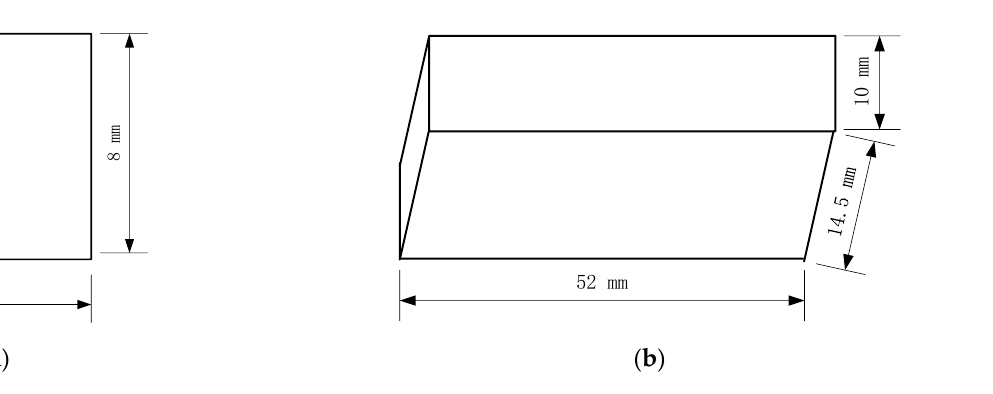
Figure 2. The SLM samples ( a ) Single layer sample (8 mm × 8 mm); ( b ) Cuboid sample (10 mm × 52 mm × 14.5 mm).